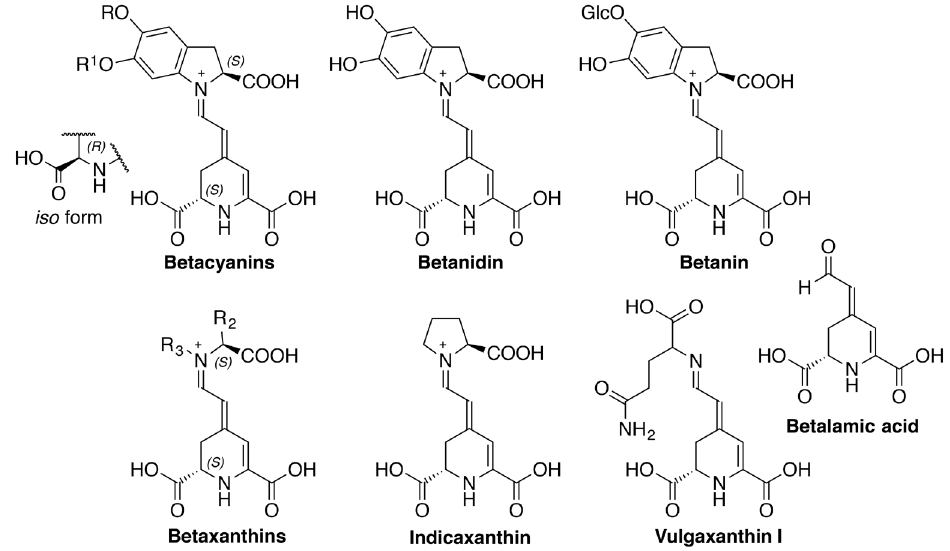
Figure 2 - Generic structures of betacyanins and betaxanthins, their biosynthetic precursor betalamic acid and several examples of naturally occurring